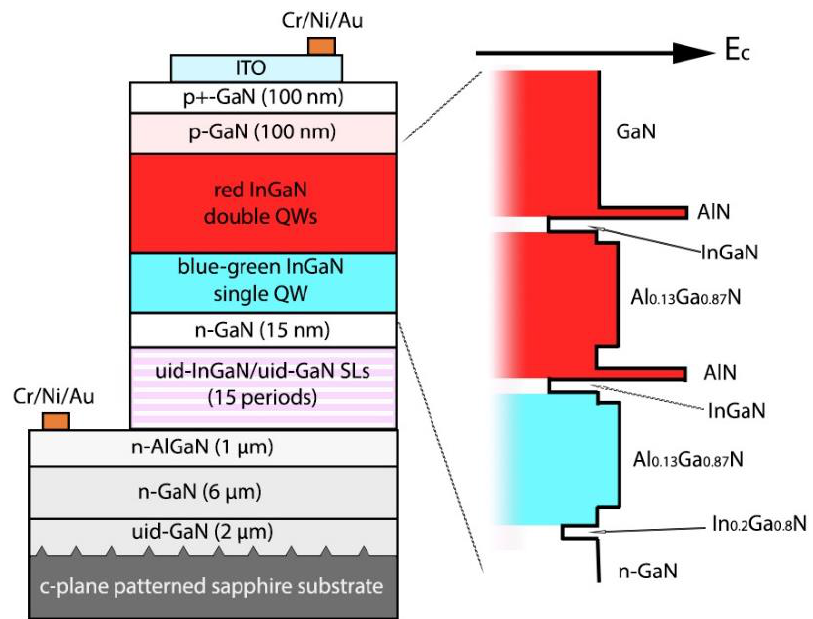
Figure 1. Red indium gallium nitride (InGaN) light-emitting diode (LED) epistructure and conduction band profile in the active region.